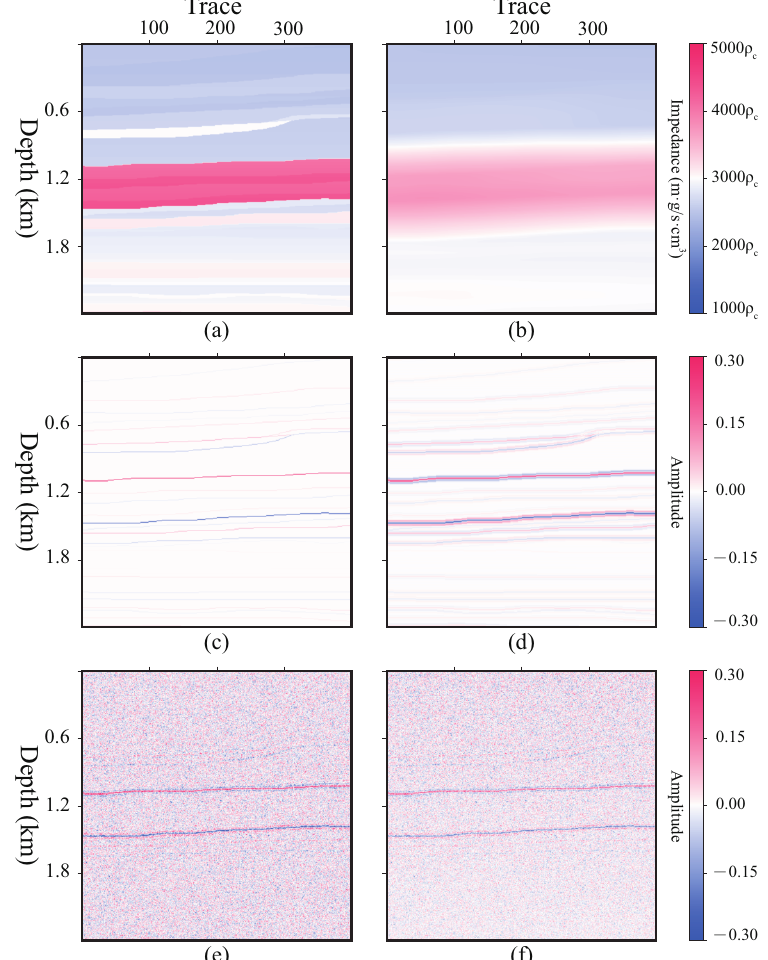
Figure 4. Dataset generation. ( a ) Impedance profile Z with constant density ρ c , ( b ) background impedance B , ( c ) reflection coefficient profile R , ( d ) seismic profile M (cid:48)(cid:48) with convolution by K = 0.030, P = 0 ◦ Ricker wavelet, ( e ) seismic profile M (cid:48) with SNR = − 5.00dB, ( f ) seismic profile M with linear